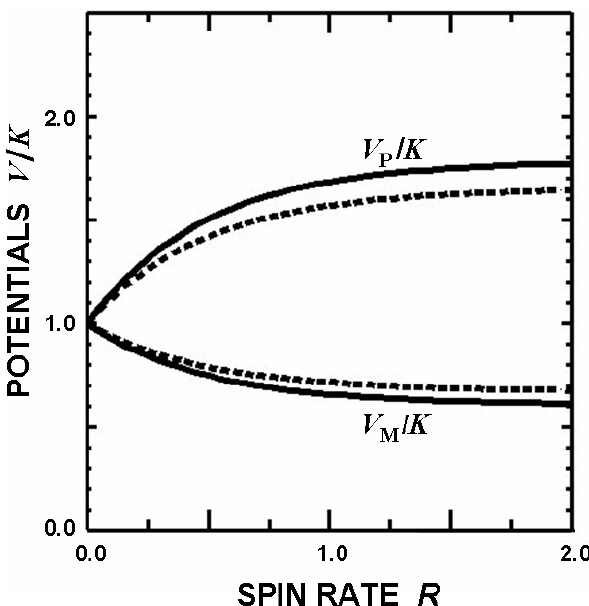
Fig. 5. The photoemission sheath angle, φ b , at the maximum sheath radius, versus R